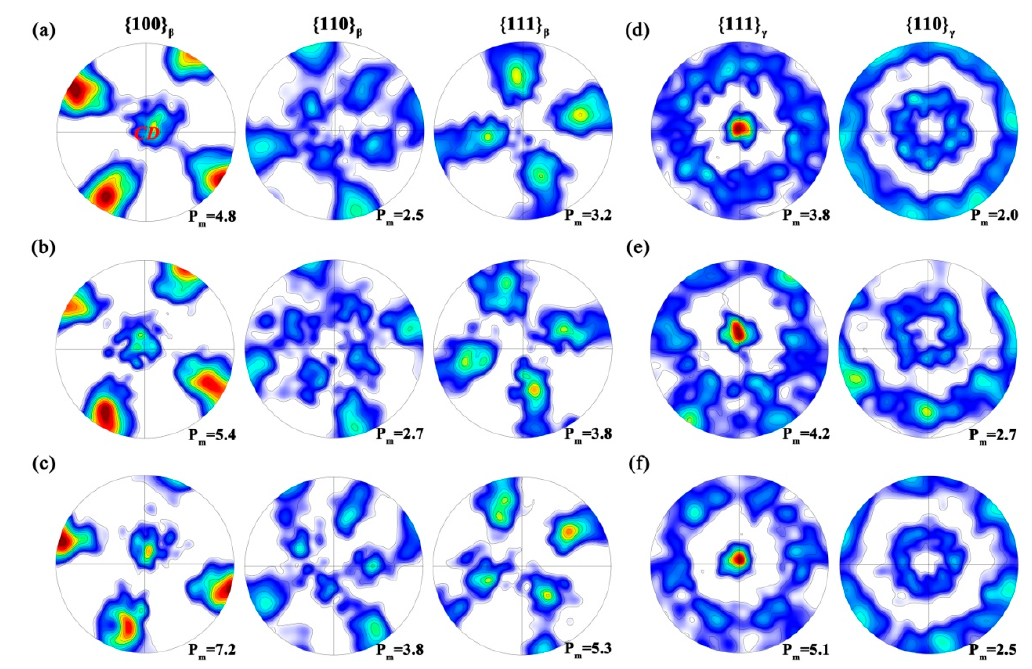
Figure 7. Pole figures for ( a – c ) β and ( d – f ) γ phase at ( a , d ) 950 °C; ( b , e ) 1000 °C and ( c , f ) 1050 °C, under a constant strain rate of 0.05 s − 1 .. The maximum intensity is listed in the bottom-right for each pole figure.